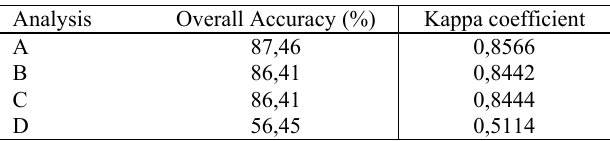
Table 4.Classification accuracy of analysis